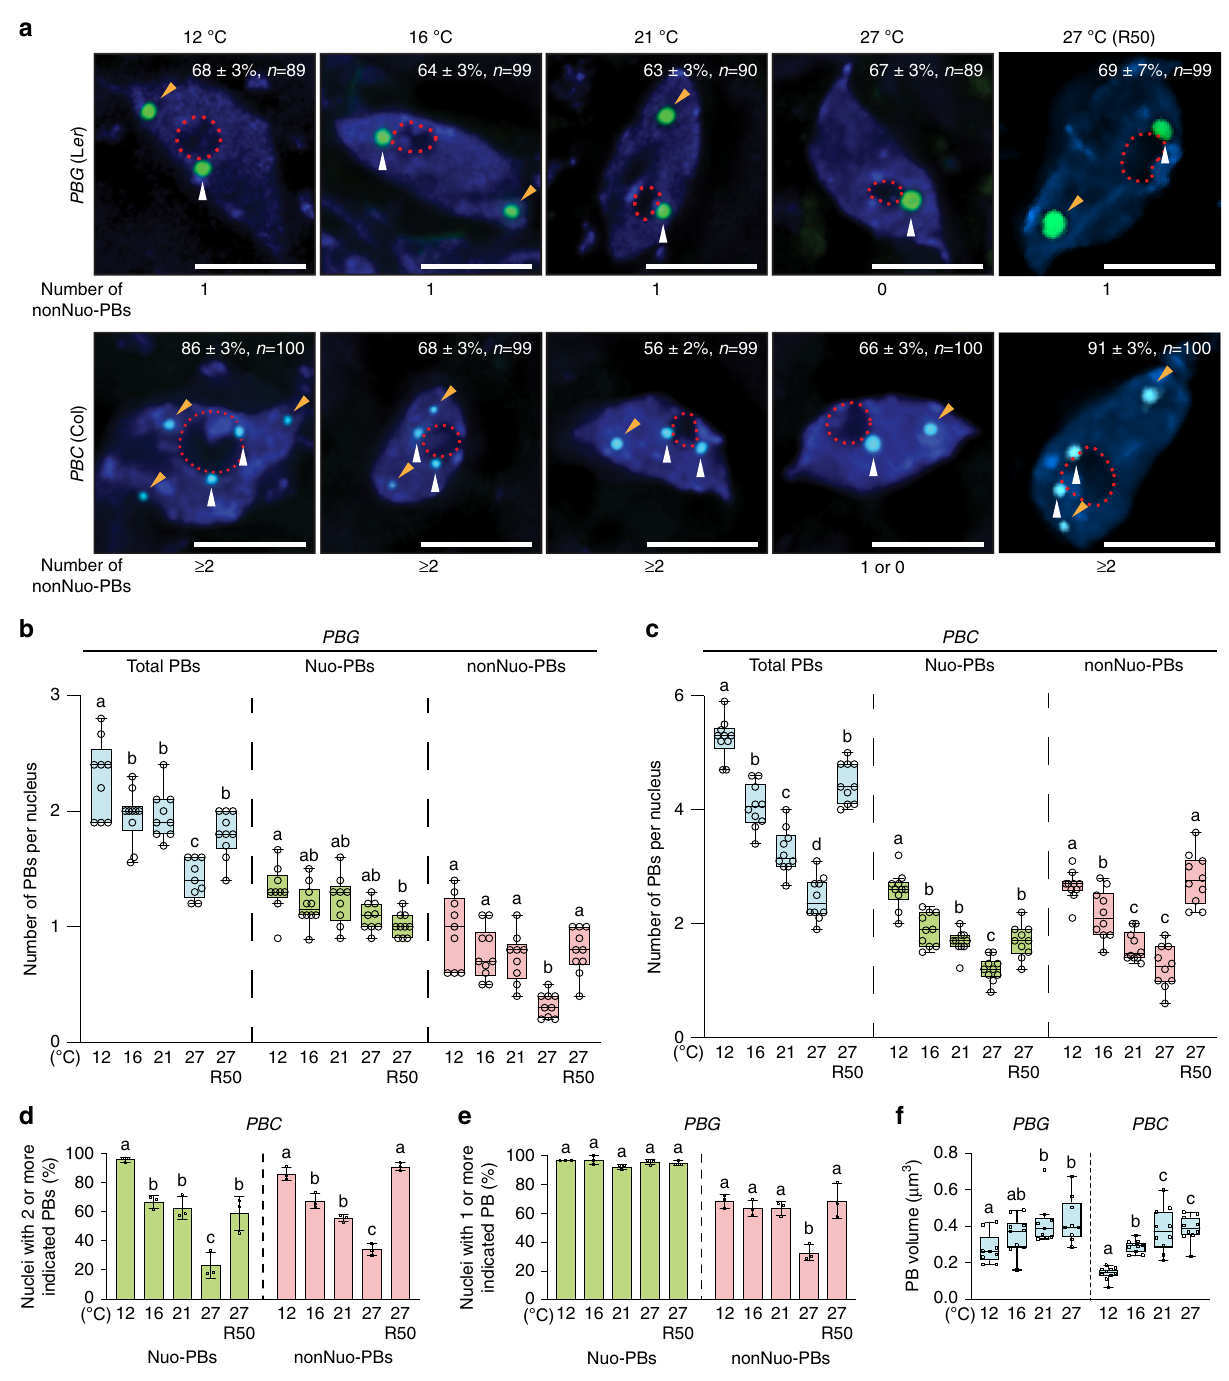
Fig. 3 Temperature-dependent photobody dynamics in cotyledon epidermal cells. a Maximum-projection, deconvolved fl uorescence microscopy images showing representative steady-state patterns of phyB-GFP (green) or phyB-CFP (cyan) PBs in cotyledon epidermal-cell nuclei of 4-day-old PBG or PBC seedlings, respectively, grown under 10 µ mol m − 2 s − 1 R light at 12, 16, 21, and 27 °C, as well as under 50 µ mol m − 2 s − 1 R light at 27 °C (R50). Nuclei were labeled by DAPI (blue), and the boundaries of nucleoli are traced by red dashed lines. Nuo-PBs and nonNuo-PBs are indicated by white and orange arrowheads, respectively. The percentage (with s.e.) of nuclei with the indicated PB pattern is shown in each image; n indicates the total number of nuclei analyzed. Scale bars represent 5 μ m. b , c Quanti fi cation of the numbers of total, Nuo, and nonNuo PBs per nucleus in cotyledon epidermal-cell nuclei of the PBG ( b ) and PBC ( c ) seedlings described in a . d Quanti fi cation of the percentages of nuclei in cotyledon epidermal-cell nuclei with two or more either Nuo- or nonNuo-PBs in the PBC seedlings described in a . e Quanti fi cation of the percentage of nuclei in cotyledon epidermal-cell nuclei containing one or more either Nuo- or nonNuo-PB in the PBG seedlings described in a . For d , e , error bars represent s.e. calculated from groups of seedlings. Different letters denote statistically signi fi cant differences (ANOVA, Tukey ’ s HSD, P ≤ 0.05, n = 3). f Quanti fi cation of the volume of PBs in cotyledon epidermal-cell nuclei of the PBG and PBC seedlings described in a . For b , c , f , the boxes represent from the 25th to the 75th percentile, and the bars equal the median values. Samples with different letters exhibit statistically signi fi cant differences in PB number (ANOVA, Tukey ’ s HSD, P ≤ 0.05, n ≥ 9). The source data underlying the PB measurements in b – f are provided in the Source Data fi